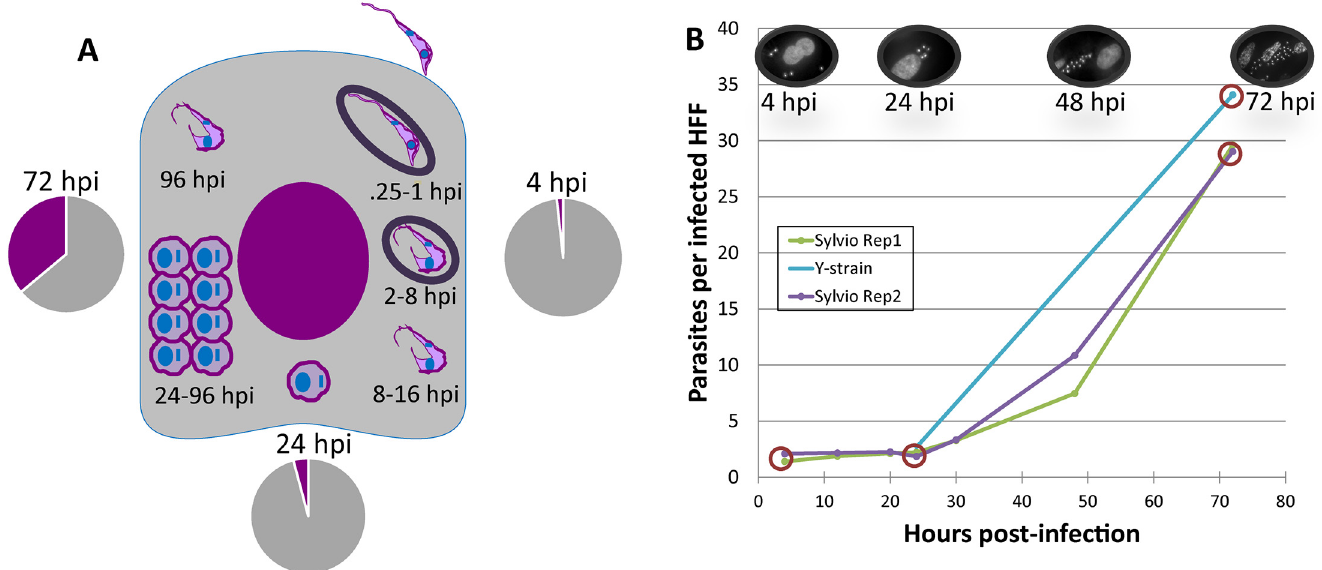
Fig 1. Study design and infection dynamics of two strains of Trypanosoma cruzi . A. Schematic representation of samples collected from the infection of human foreskin fibroblasts (HFF) with T . cruzi Sylvio strain. The expected progression of the T . cruzi infection is shown. Briefly, the parasite invades the cell within 15 minutes of attachment, and is enclosed by a portion of the host cell membrane (parasitophorous vacuole). By 4 hours post- infection (hpi), the parasite begins to transform from infective trypomastigote to the intracellular amastigote; it exits from the parasitophorous vacuole at around 8 hpi. The parasite completes its transformation by 24 hrs and starts dividing. By around 96 hpi, the parasite begins the transformation back to the trypomastigote form. The trypomastigotes then escape the cell and the infection process begins anew. Two independent infections were carried and total RNA was collected at three time points (4, 24 and 72 hpi), from both infected cells and tissue culture typomastigotes. Libraries were prepared and sequenced for each of the two biological replicates at each timepoint. Pie charts show the average proportion of RNAseq reads mapping to the human (gray) and parasite (purple) reference genomes for each of the intracellular timepoints. Mapping details are provided in S1 Table. B . Parasite burden per cell is shown for each timepoint in each experiment. One hundred DAPI-stained cells were counted on each of three independent coverslips on a Zeiss AxioObserver microscope at 100x oil-immersion. A parallel Y-strain infection was run for a comparison with the existing Y strain dataset [26]. Samples from circled timepoints were sequenced.